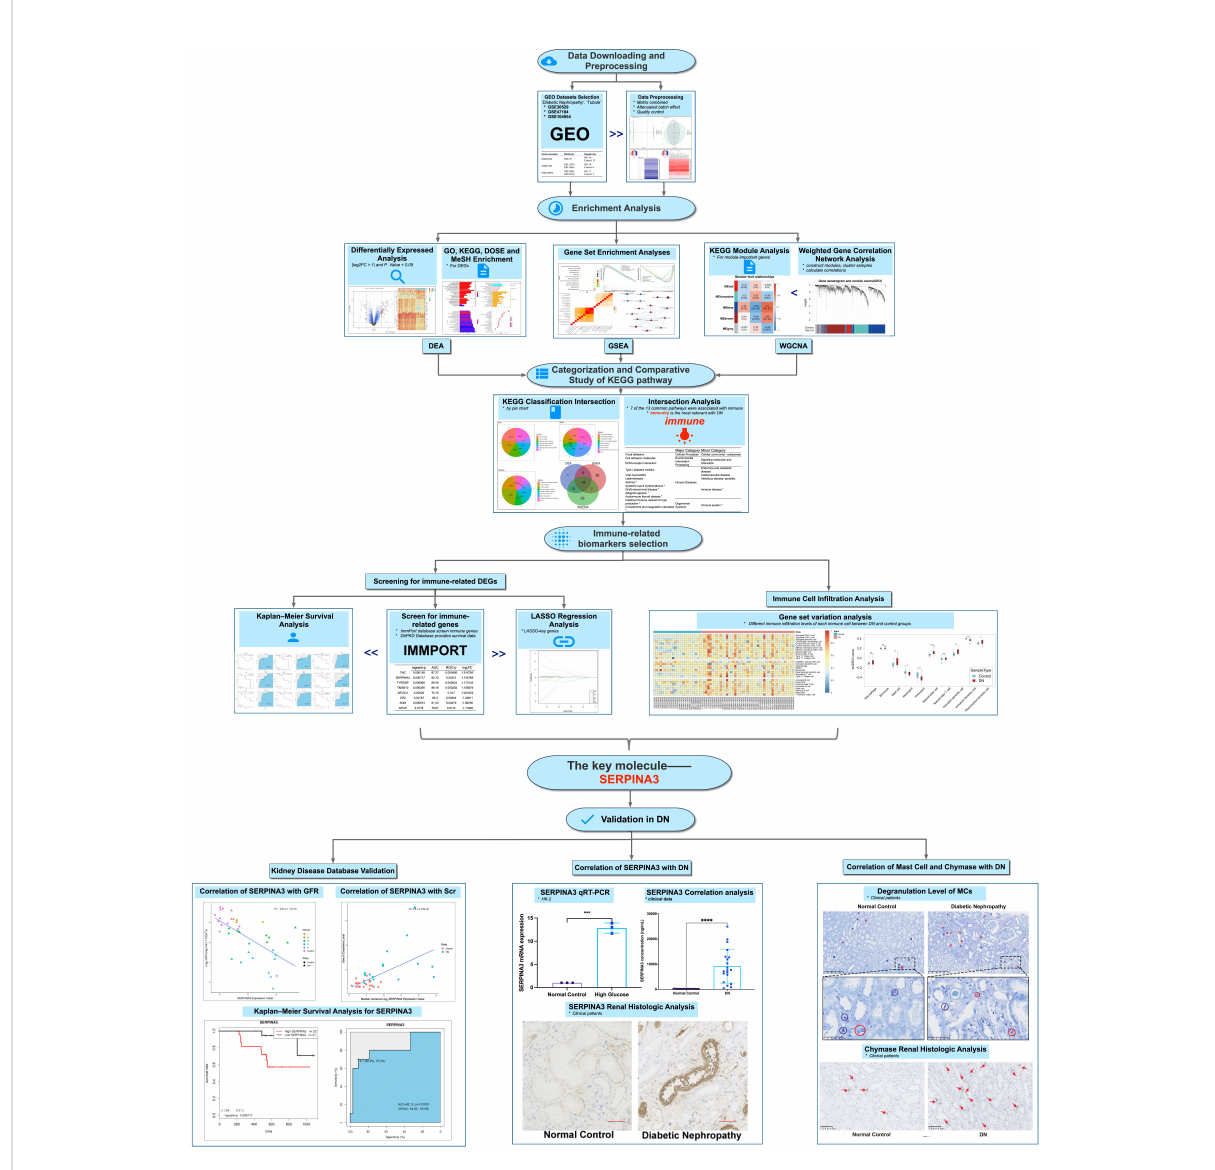
FIGURE 1 Work fl ow of the study. *P < 0.05, **P < 0.01, ***P < 0.001, and ****P < 0.0001; ns, no signi fi